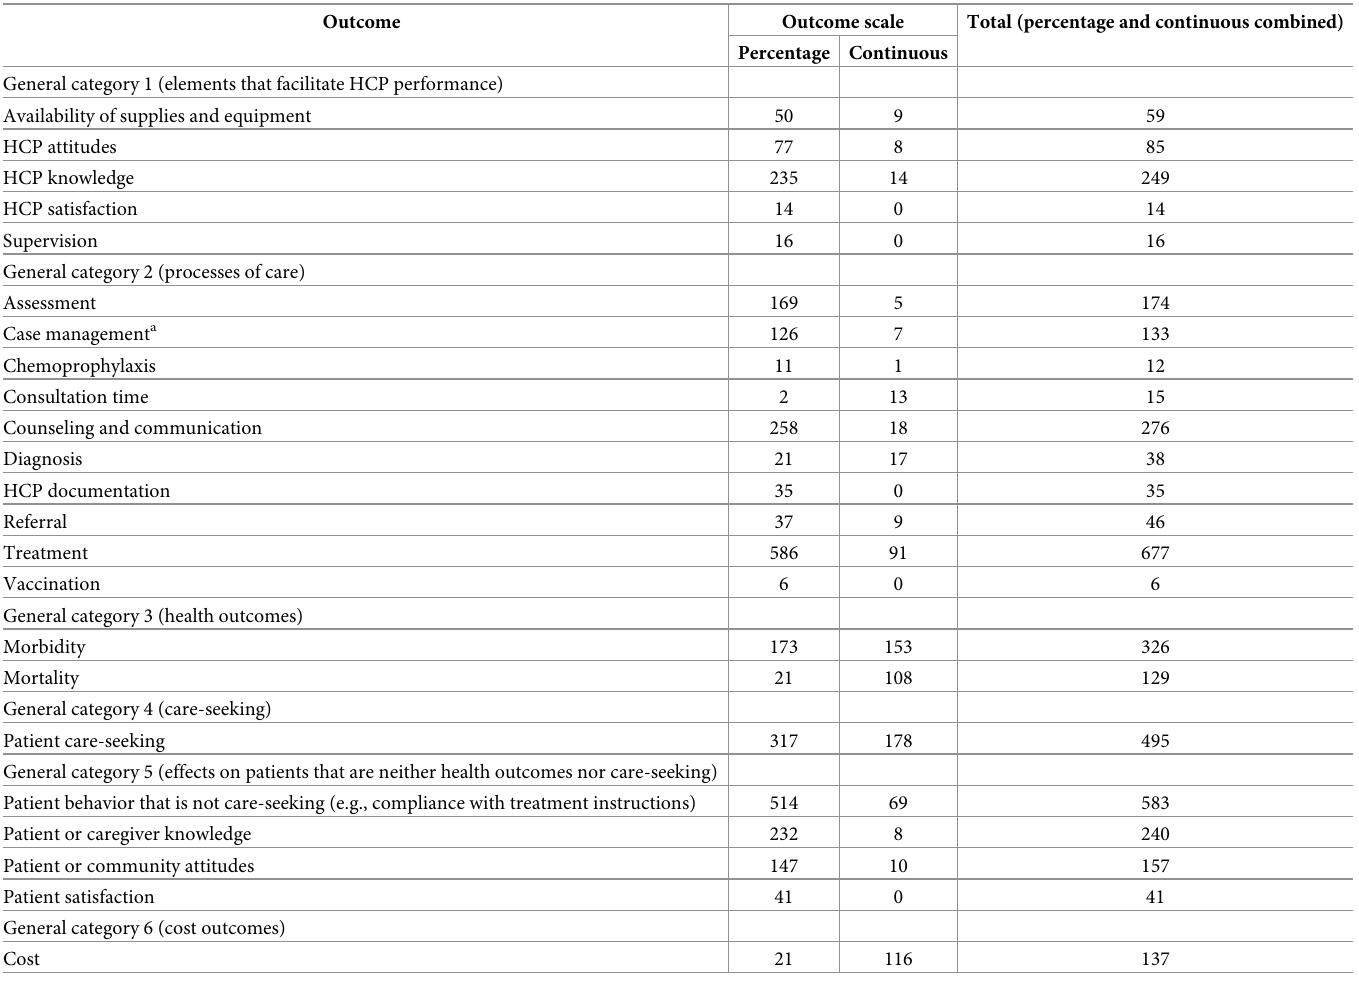
Table 7. Categories of all 3943 effect sizes from all 499 included